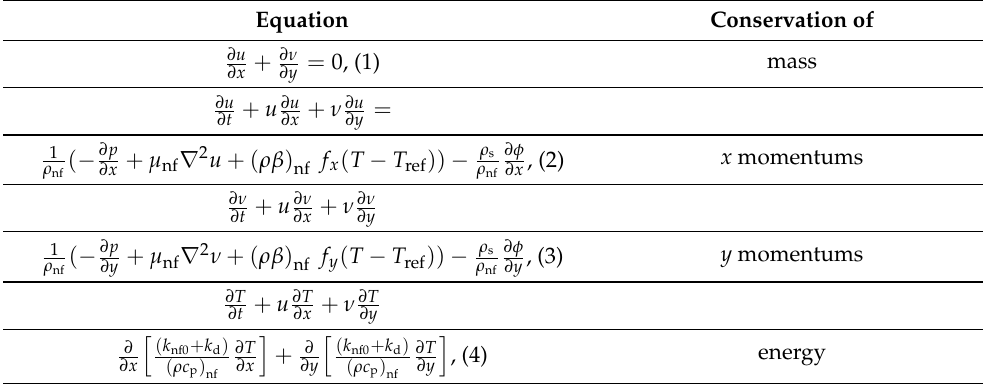
Table 1. Governing equations of fluid [2].